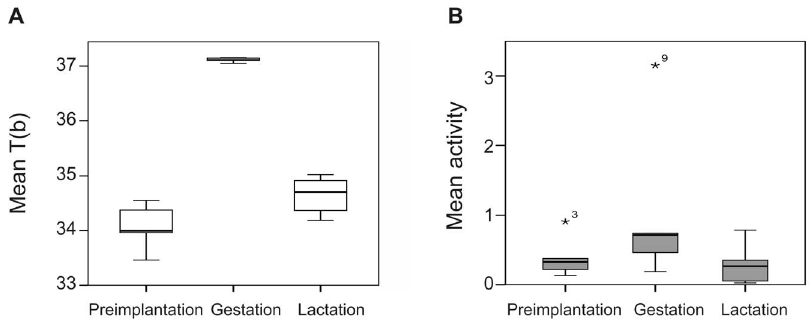
Figure 2. Mean body temperature (T(b)) (A) and mean activity (B) during preimplantation, gestation, and lactation periods for pregnant females brown bears (N=6) in Sweden, during 2010–2013. We calculated the dates of implantation and parturition with body temperature data. Preimplantation was defined as the 14-day period before implantation occurred and lactation was defined as the 14-day period after parturition. Extreme outliers are plotted as asterisks. In figure B, the highest activity values in all periods originate from the same pregnant female.